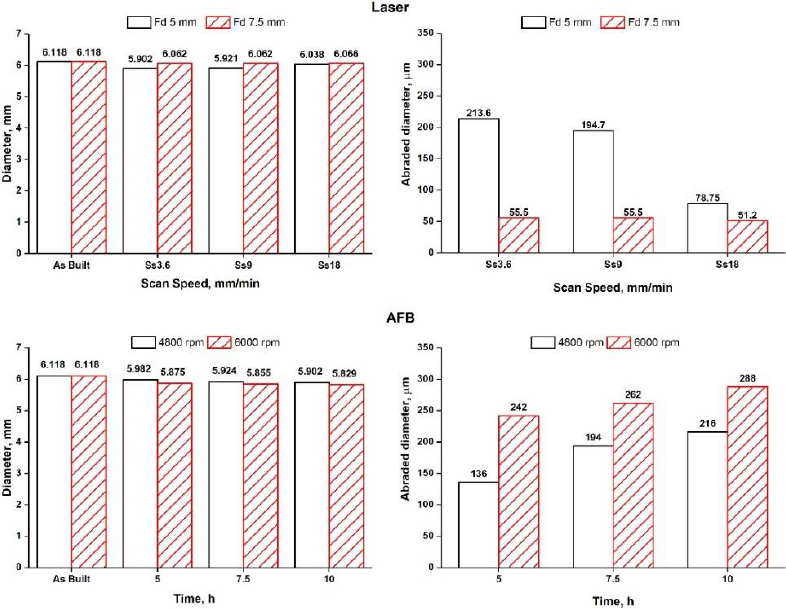
Figure 7. Dimensional variation of the treated samples at different process conditions.